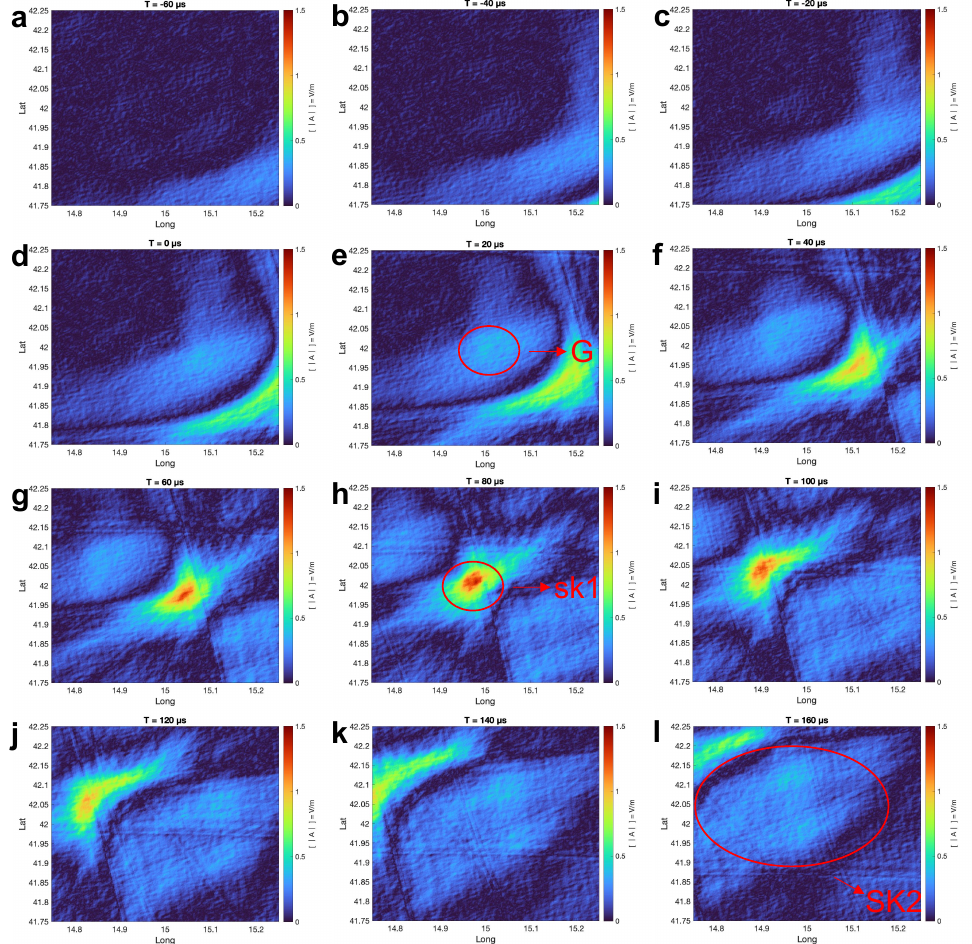
Figure 9. The scaled amplitude maps with 105 receiver network with a simulated lightning location of 15°E and 42°S. Each sub-figure ( a – l ) is the amplitude map of a different time frame. Figure 9 shows the apparent lightning energy movement. Since the global abso- lute maximum value is 1.34, the colour scale limit of the scaled amplitude map is set to 0–1.5 considering the waveform value cancelling. Compared to the first skywave, the area associated with the ground wave has a much smaller value in scaled amplitude maps. The ground wave has a comparable value to the second skywave, while the second skywave covers a larger area. The first skywave is predominant in the dynamic amplitude maps. To quantitatively analyse the amplitude maps, the ground wave arrives at the simulated lightning location in the time frame of 20 µ s, with a value of ∼ 0.4. Then, the first skywave starts to move towards the simulated lightning location and reaches the centre between the time frame 60 µ s and 80 µ s. The maximum value in these two frames is ∼ 1.3. The second skywave arrives at the simulated lightning location in the time frame of 160 µ s with a